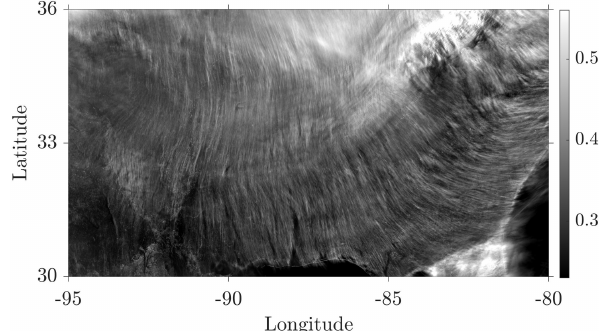
Figure 2. The time-averaged corrected reflectance field X . Note the clear stripes in X , marking the nearly stationary behavior of cloud streets along the mean CBL wind